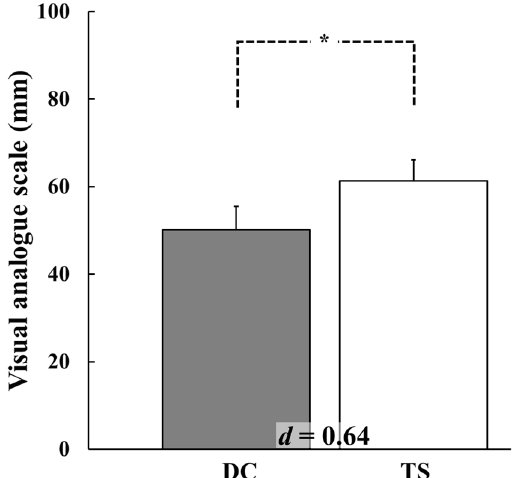
Figure 2. Effect of the type of clothing worn on subjective gait sensation during the tandem gait test. A range from 0 mm (able to walk easily, similar to the task with eyes open in the pilot experiment) to 100 mm (difficult to keep tandem while standing upright). Values are expressed as mean ± standard error of the mean. *: p < 0.05.